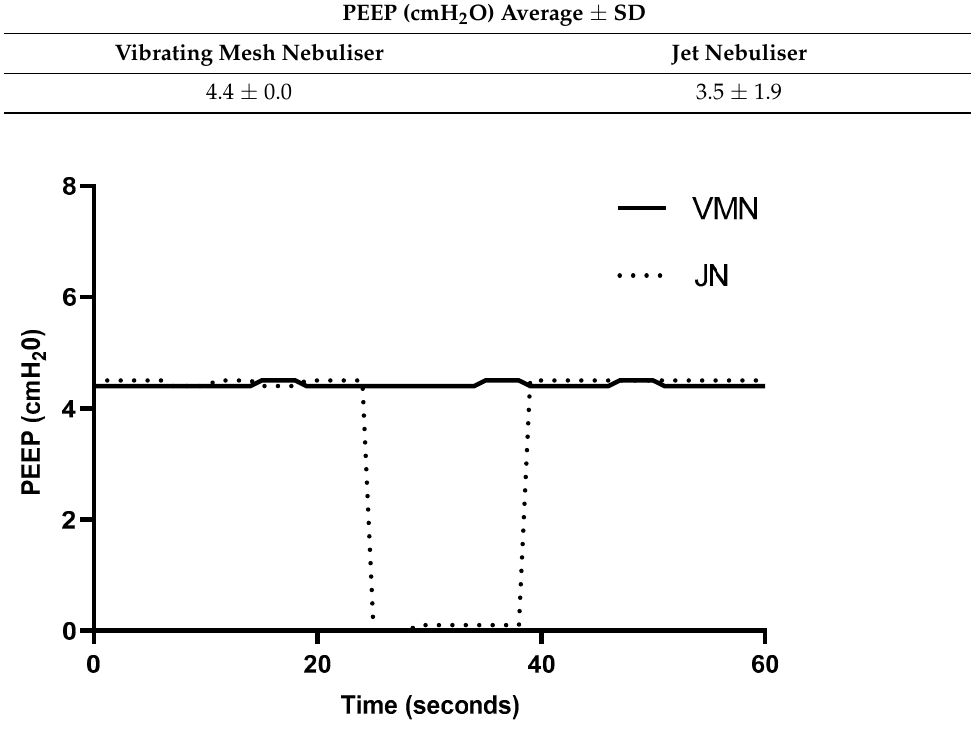
Figure 5. Comparison of PEEP during nebuliser drug refill of a simulated mechanically ventilated patient.